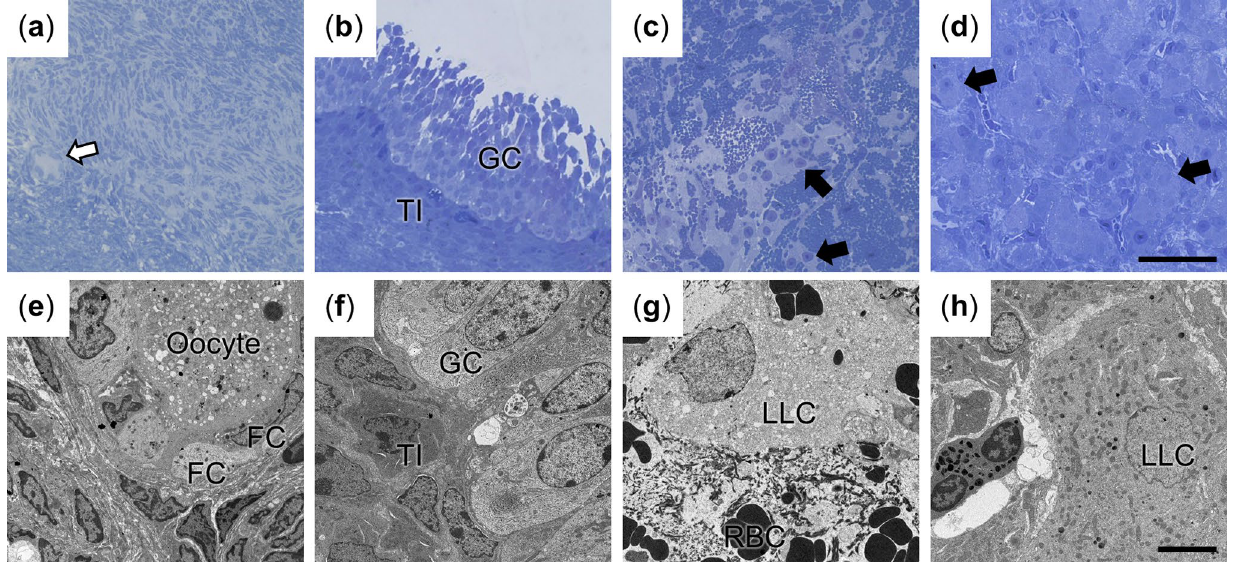
Figure 2. Representative images show the lineage of LLCs in goat ovarian tissues at a cellular level. ( a – d ) The images depict PF (white arrow, a ), MF ( b ), CH ( c ) and CL ( d ). The black arrow indicates LLCs. Bar: 100 μm.